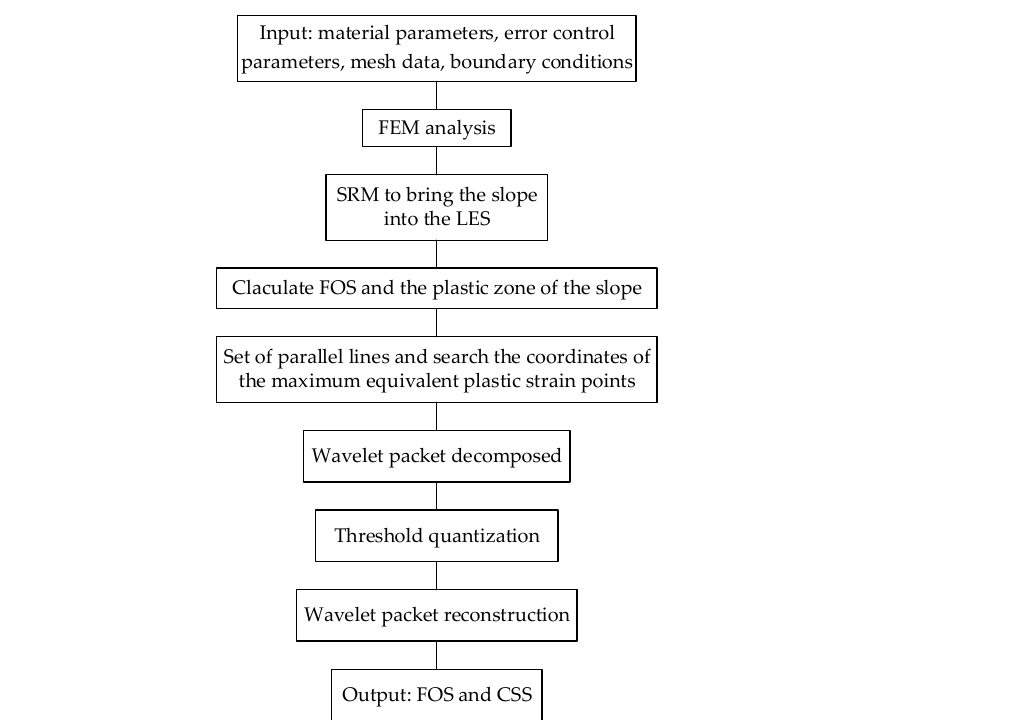
Figure 2. Flow diagram for the proposed method.